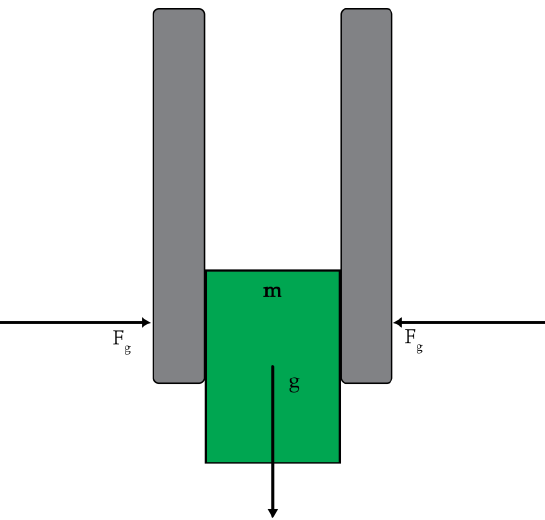
Figure 4. Friction grip model according to Coulomb ’ s friction model. Source: own.